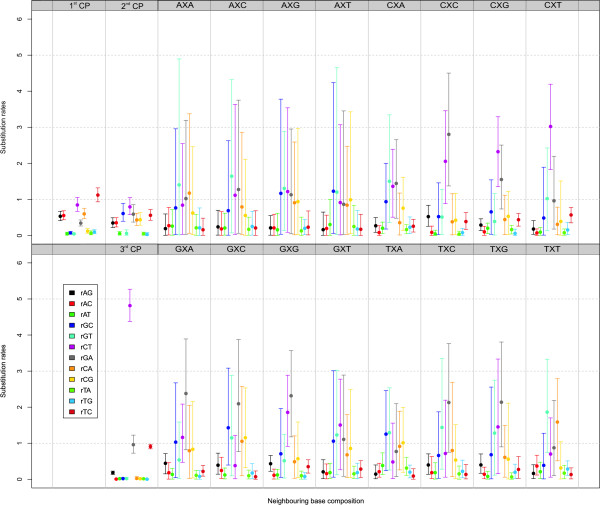
atpB dataset: Estimated substitution patterns for the independent evolutionary models at first, second and third codon positions and the context-dependent evolutionary model at the third codon position for the GTR123+Γ123+CP123+F123+FF16+3F model. At the left of this figure, i.e. the first two columns, the independent model estimates for first (1st CP), second (2nd CP) and third (3rd CP) codon positions are shown. At the right of the figure (columns 3 through 10), the context-dependent estimates for the third codon position are shown for each evolutionary context, i.e. each neighbouring base combination. In the figure, the substitution parameter types (i.e. rAG, rAC, ..., rTC) each have a unique colour, as indicated in the legend panel within the figure, and the same colour is used for every model (context-dependent or not).